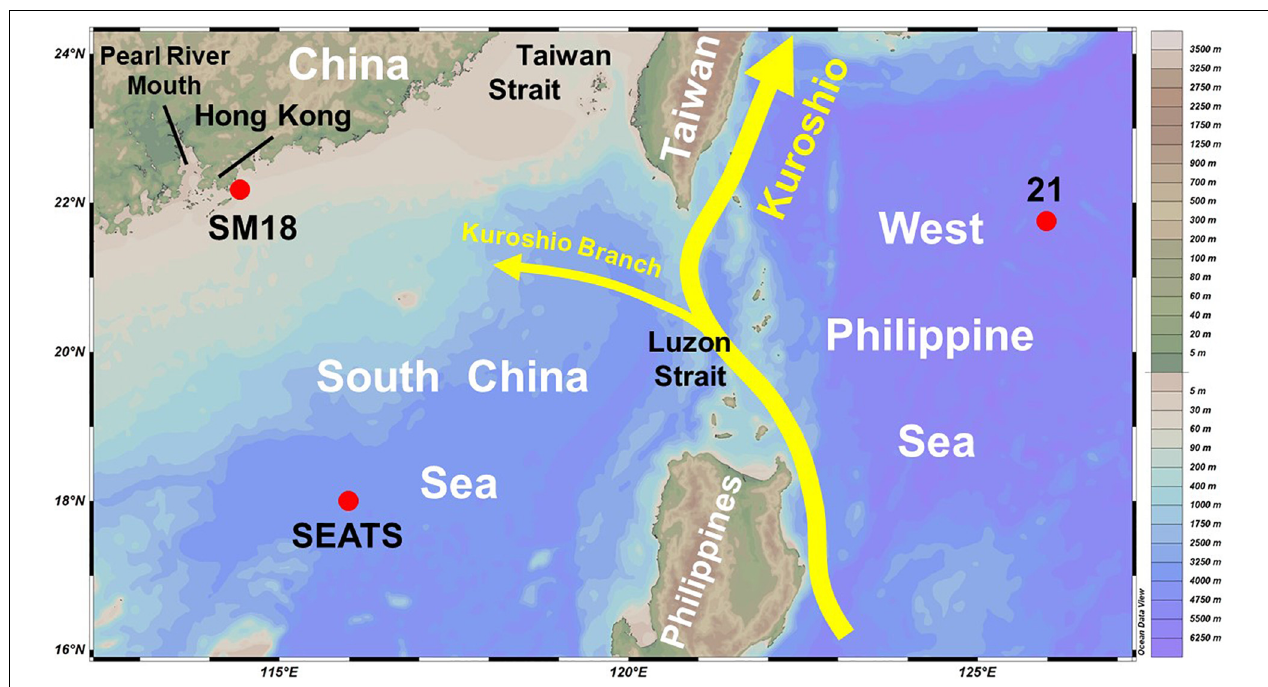
FIGURE 1 | Study areas and basic hydrology. Red solid circles indicate the station locations. The yellow curves and arrows show the typical Kuroshio current, as well as its branch. The map was generated using Ocean Data View 5.0.0. Schlitzer, R., Ocean Data View, https://odv.awi.de,